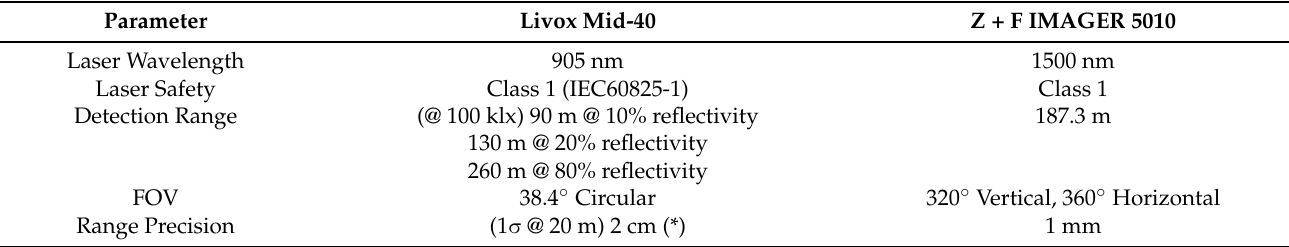
Figure 3. Reshaped field of view; plot of horizontal situation. Table 1. Livox Mid-40 [29] and Z + F IMAGER 5010 [30] parameters. (*) Measured in an environment of 25 ◦ C with a target (80% reflectivity) 20 m away. The result may vary under different test